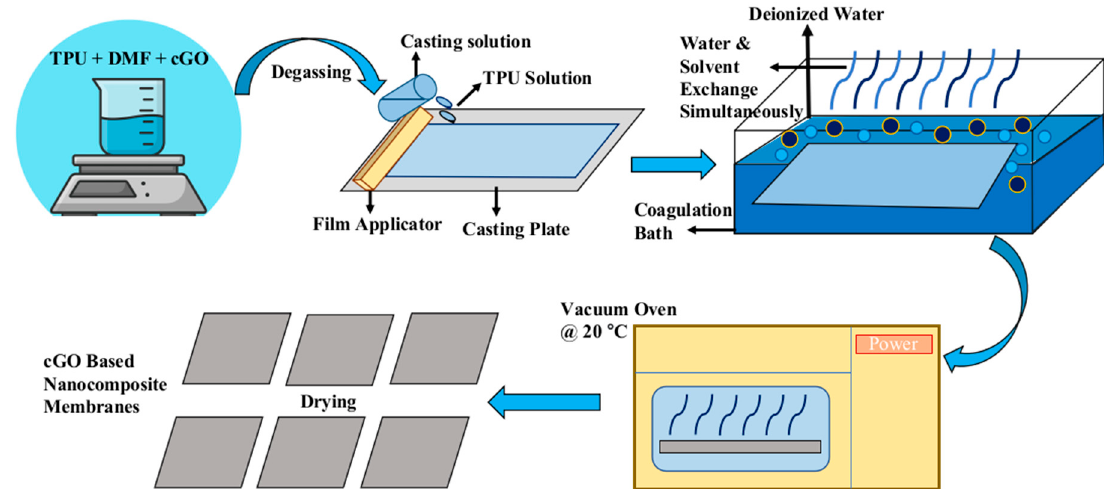
Figure 1. Schematic representation of phase inversion method.